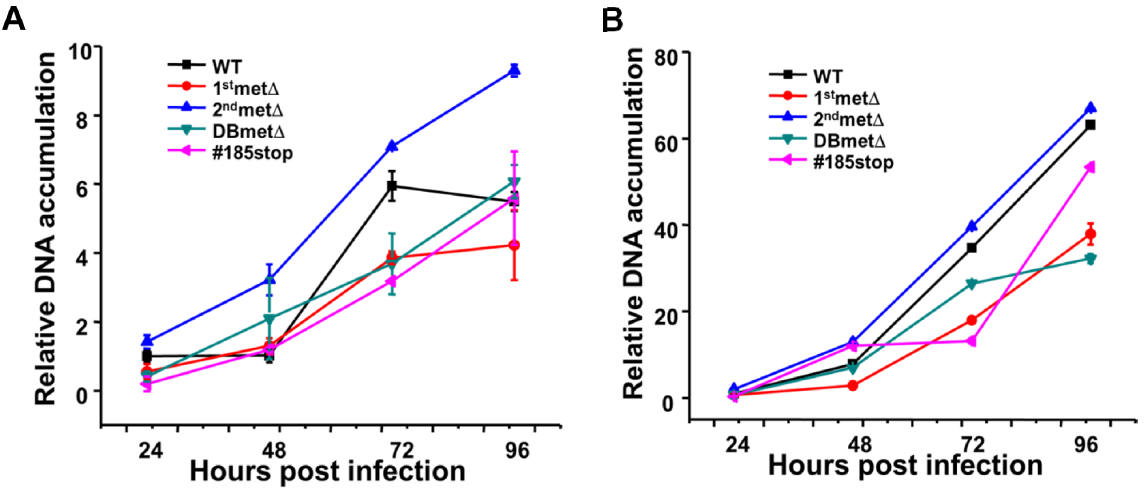
Figure 4. Accumulation of viral DNA after infection with U L 26 recombinant viruses. ( A ) Serum starved MRC5 fibroblasts were infected with the indicated recombinant virus at an MOI of either 3.0 ( A ) or 0.25 ( B ). Viral DNA was collected at 24, 48, 72 and 96 hpi. Real-time PCR was performed using HCMV-specific primers to analyze viral DNA accumulation. Values are means 6 SD (n=3).